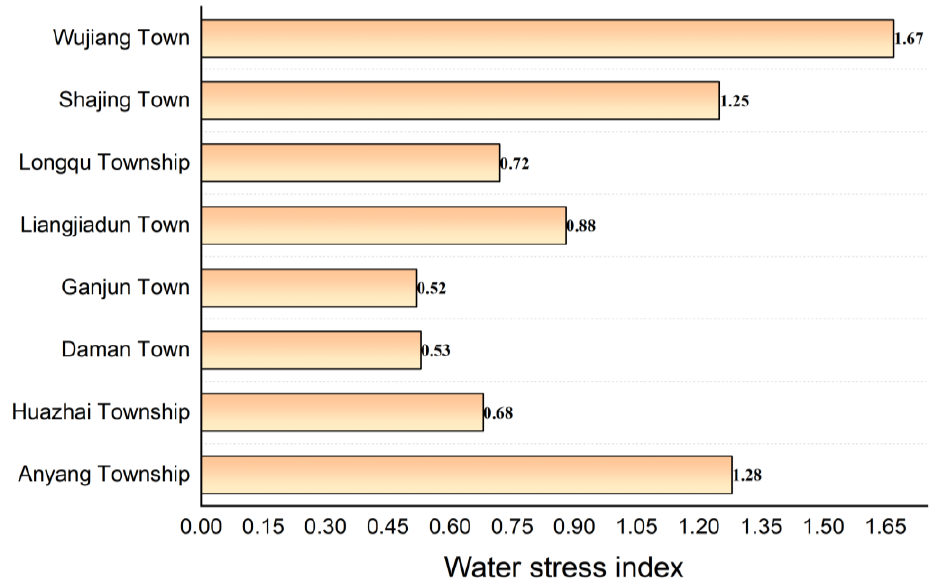
Figure 5. Evaluation results of water stress index of typical townships. Table 6. Evaluation results of WRCC of typical townships in Ganzhou District in 2021.